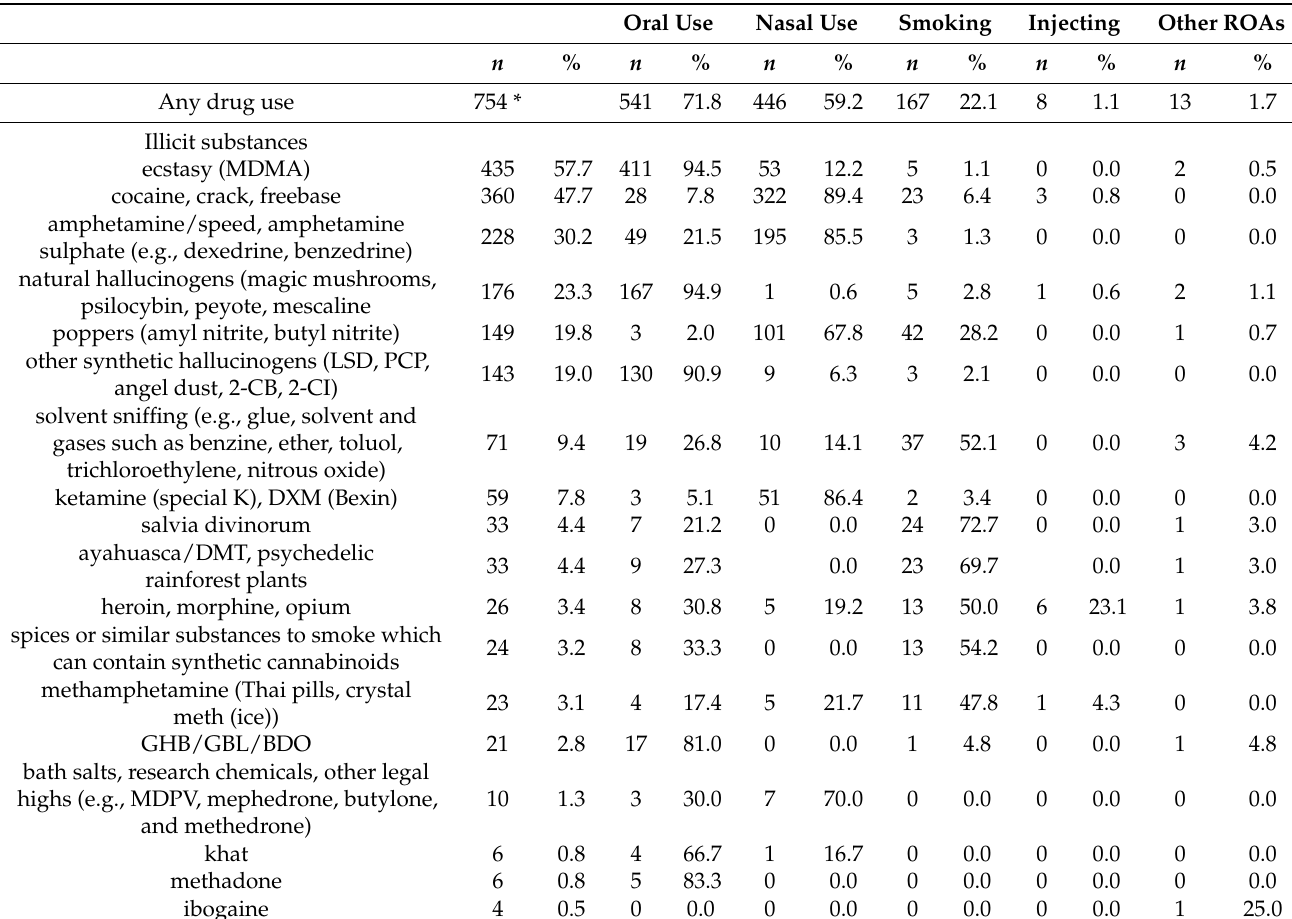
Table 1. Prevalence rates for ROAs among users of any of the 18 illicit drugs and for each of the 18 illicit drugs separately. Oral Use Nasal Use